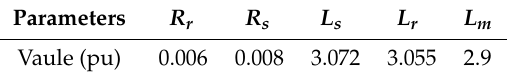
Figure A1. The relationship of A  and  with When the half-wave Fourier algorithm is used, by replacing T with T /2, the above conclusions still work.